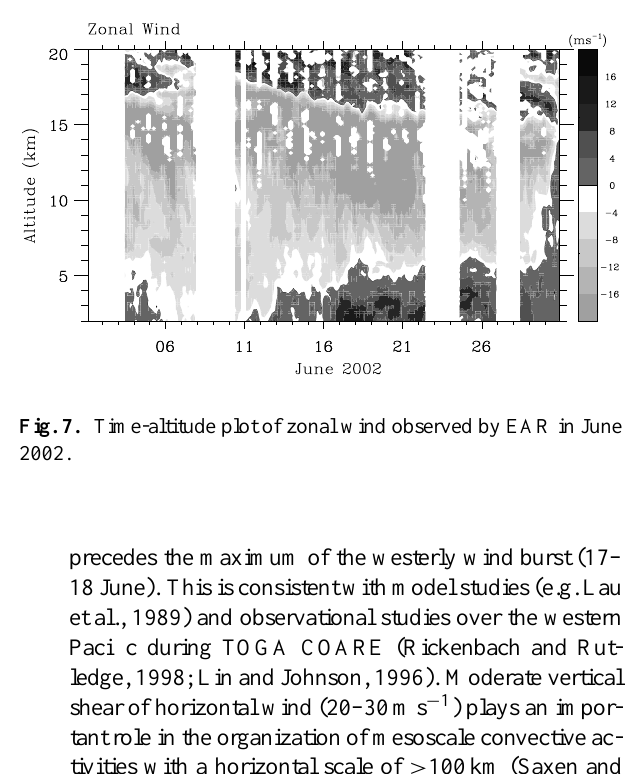
Fig. 8. Time variation of zonal wind anomalies averaged in 2–4 km Fig. 6. Time variations of (a) zonal and (b) meridional wind derived (solid curve) and 10–12 km (dotted curve) observed by EAR in June from EAR and NCEP/NCAR reanalysis. Solid and dotted curves 2002. show EAR winds averaged in 3–4.5 km and NCEP winds averaged re- in 700–600 hPa closest to the observation site ( Æ N, Æ E), (cid:1) (cid:3)(cid:1)(cid:1) spectively.